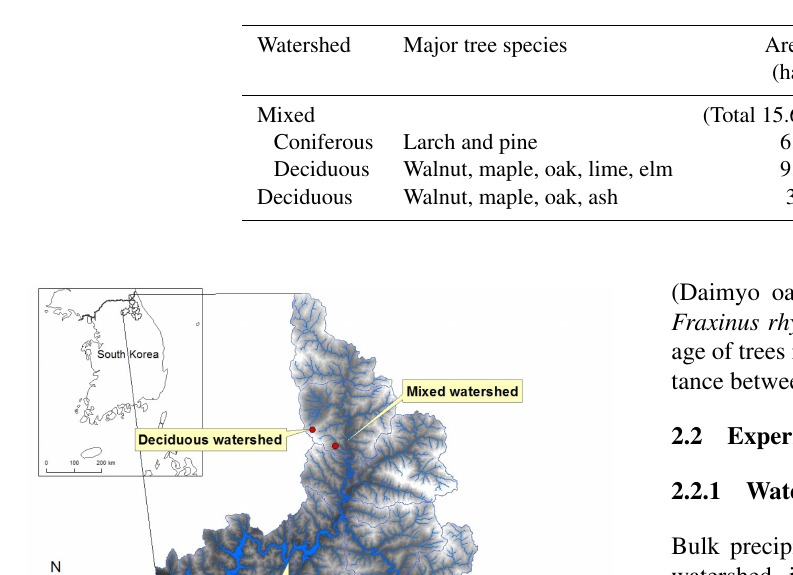
Table 1. Tree species composition and geomorphological characteristics of the studied forested watersheds.